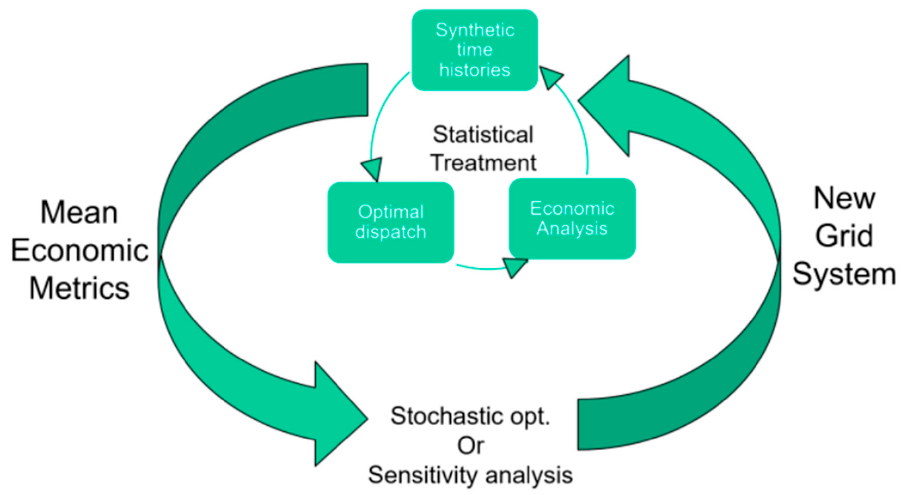
Figure 1. General schematic of the HERON dispatch model workflow [15].